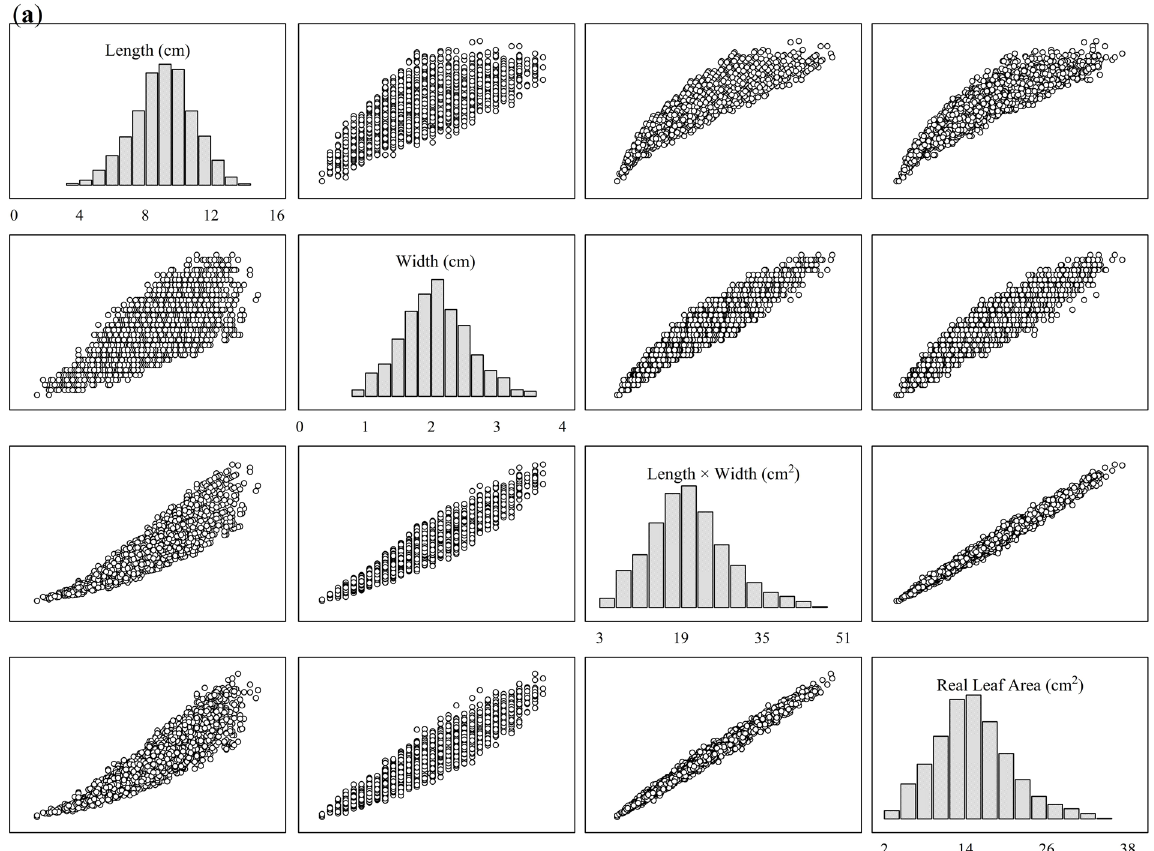
Figure 1a - Matrix with a histogram frequency (in diagonal) and dispersion graphs of length (cm), width (cm), length times width (in cm 2 ) product and real leaf area (cm 2 ) of 3,200 leaves of Crotalaria juncea